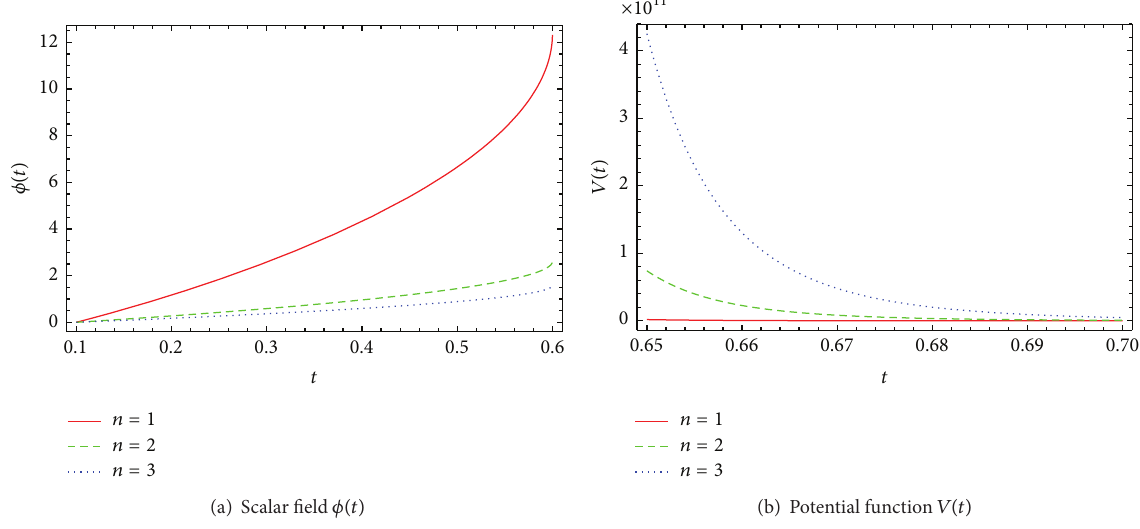
Figure 4: Plots of 𝑓(𝑅,∇𝑅) tachyon model: (a) scalar field 𝜙 versus time 𝑡 and (b) potential 𝑉 versus time 𝑡 for 𝑛 = 1 (red), 𝑛 = 2 (green), and 𝑛 = 3